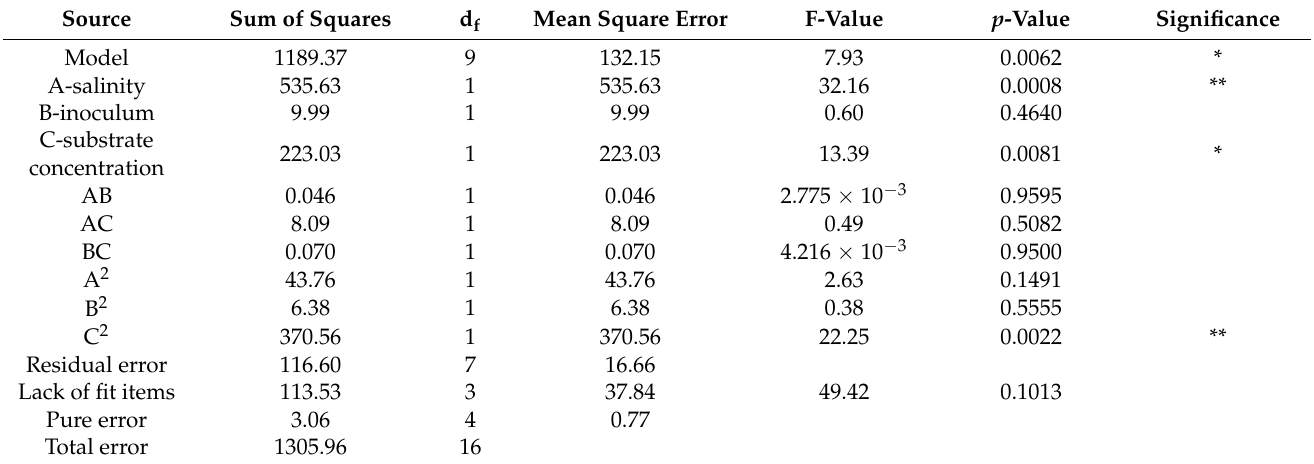
Table 4. ANOVA analysis for the response surface quadratic model of DBP degradation.